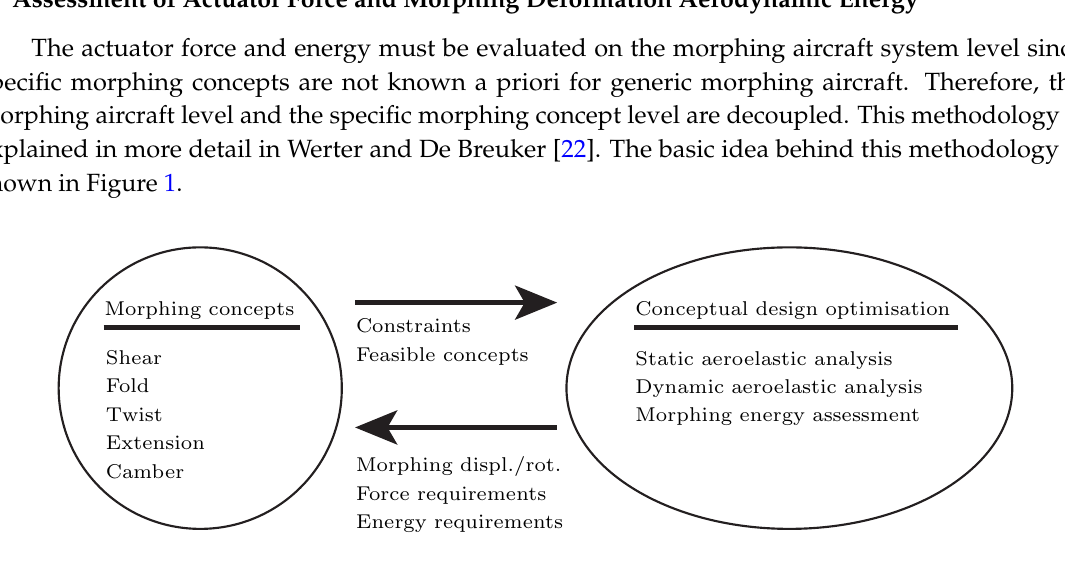
Figure 5.7: Two-level approach for morphing wing conceptual design Figure 1. Decoupled morphing aircraft and concept